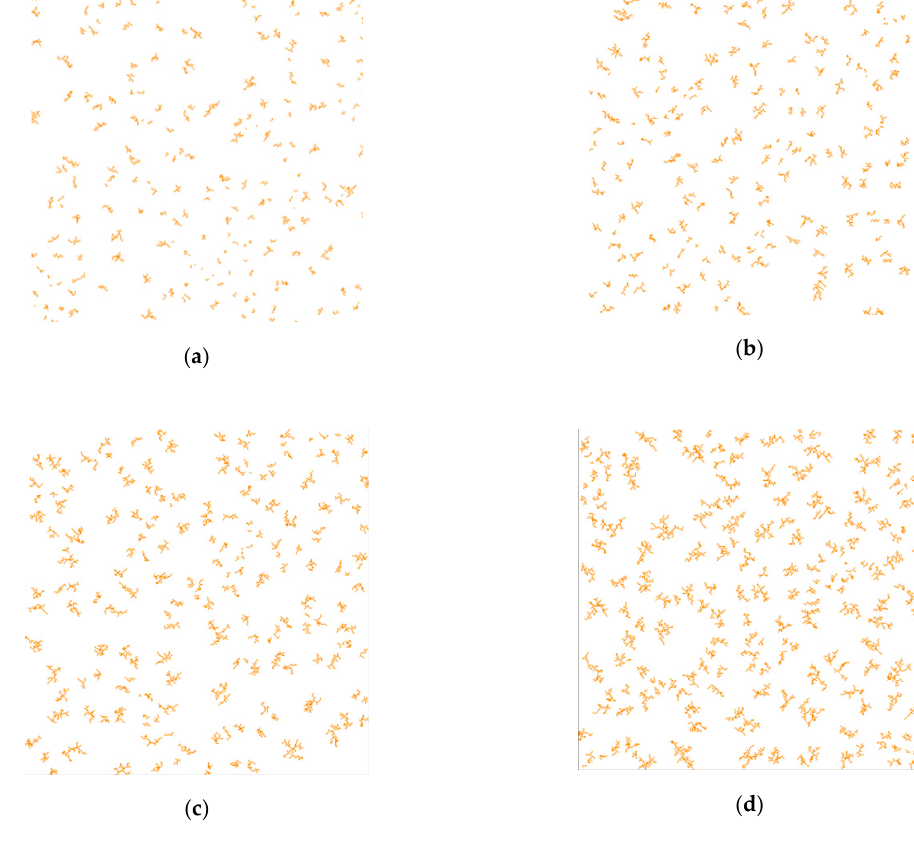
Figure 9. Two ‐ dimensional slices of porous catalyst digital structure, corresponding to the different catalyst:aniline ratio: ( a )—40 g per 1 kg aniline layer; ( b )—80 g per 1 kg aniline layer; ( c )—120 g per 1 kg aniline layer; ( d )—160 g per 1 kg aniline layer.